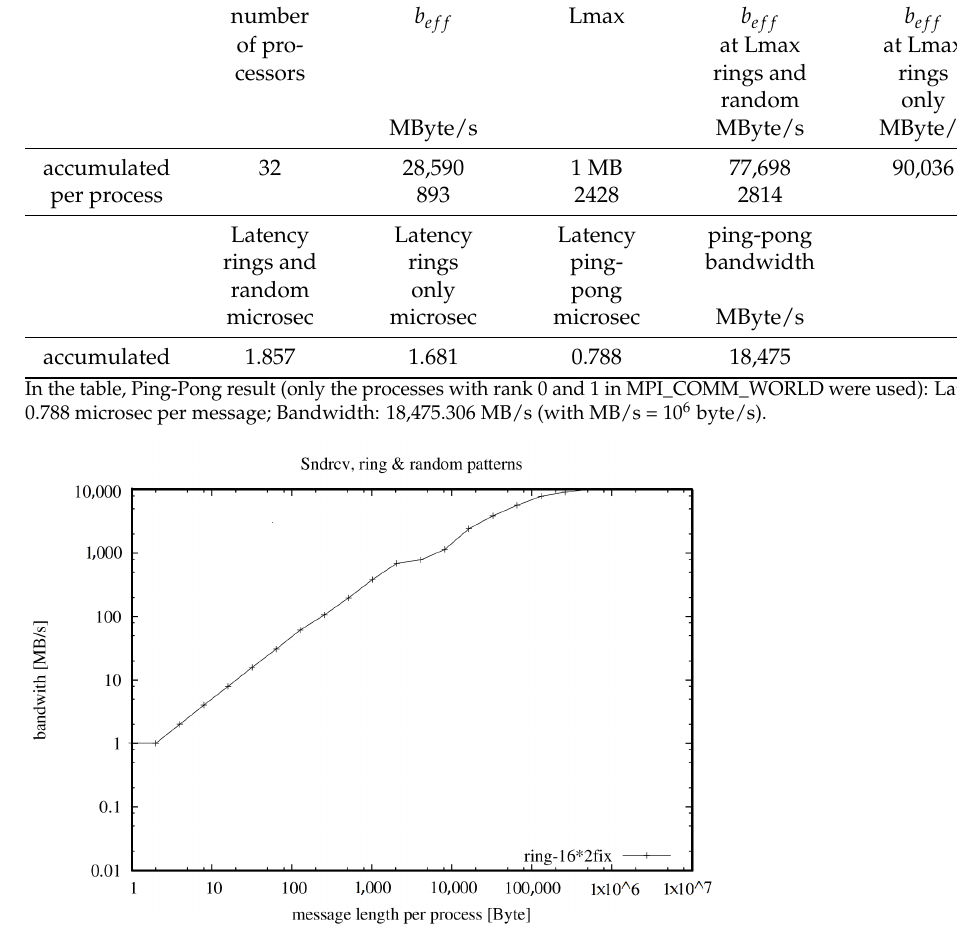
Figure 4. Bandwidth with 32 cores, one per